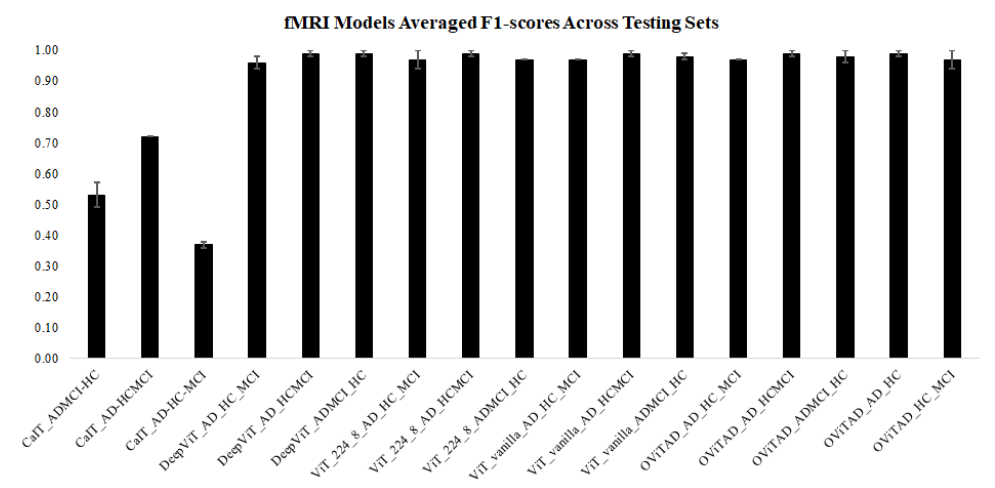
Figure A5. The summary of fMRI models’ performance using averaged F1-scores for three testing sets.